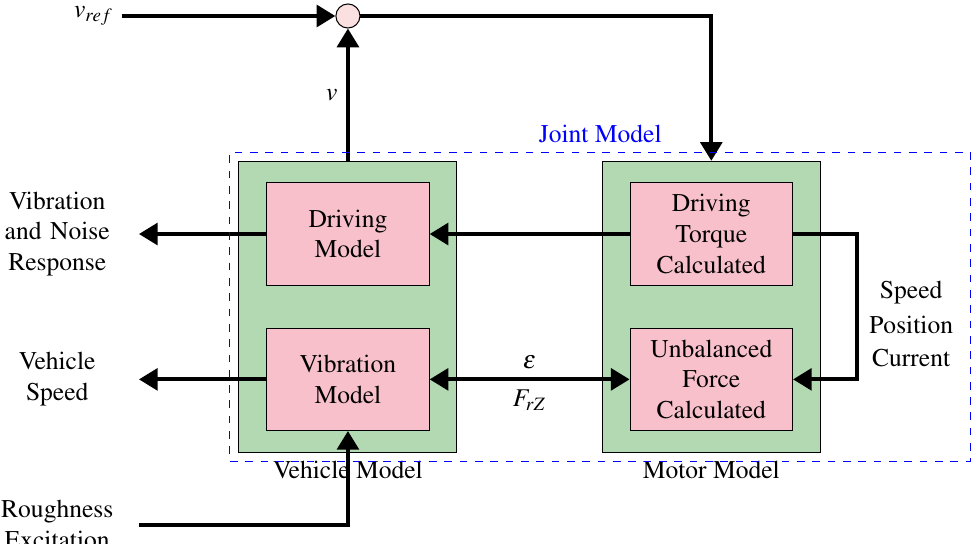
Figure 17. Electro-mechanical coupling model developed to reduce the eccentricity based faults in IWM